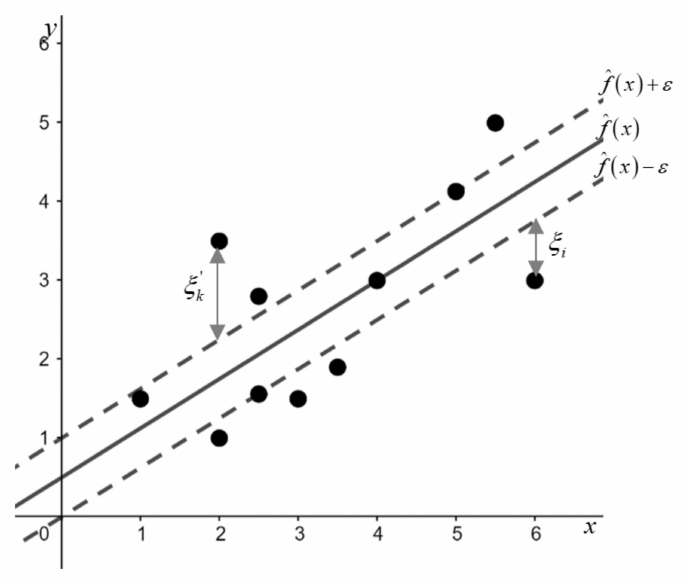
Figure 1. Support Vector